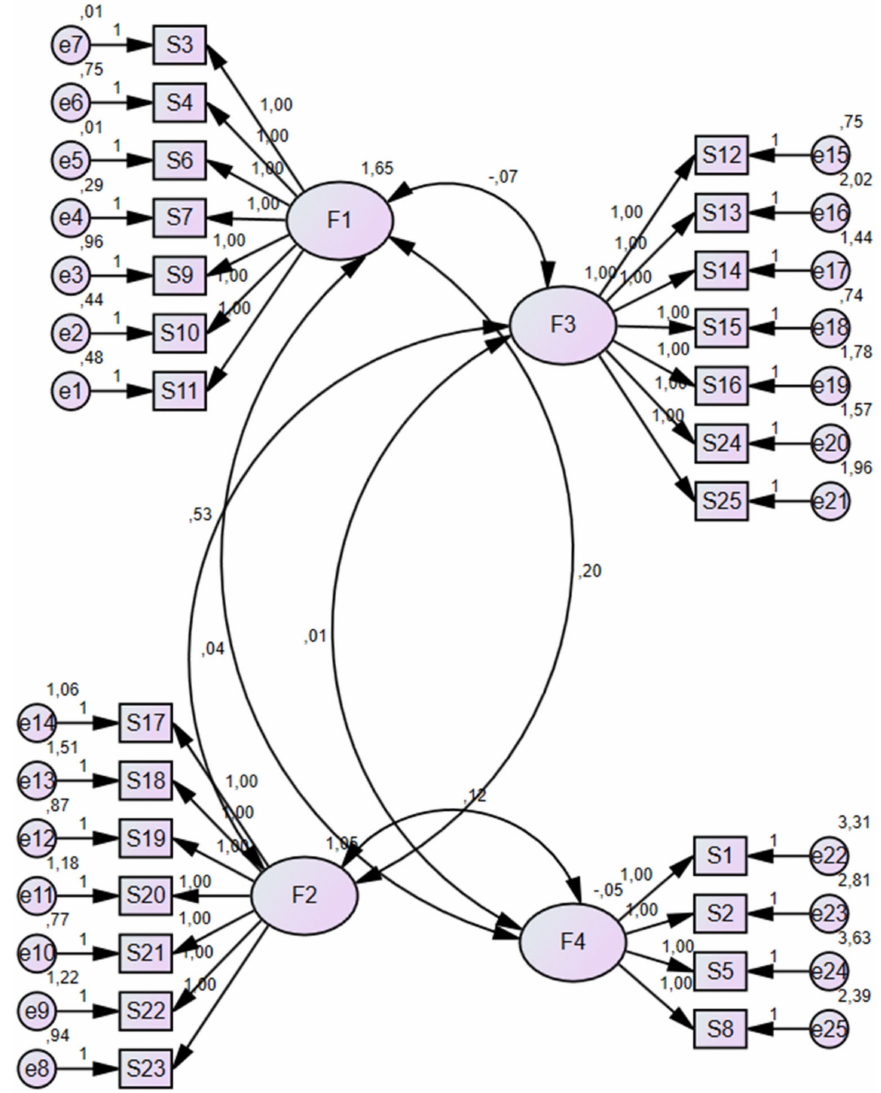
Figure 1. Structural equation model of the